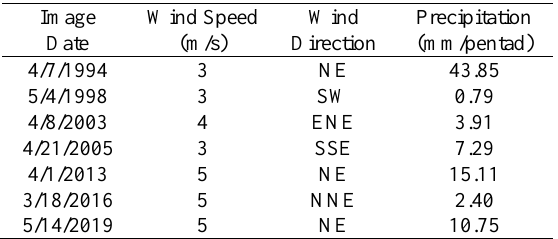
Table 3. Meteorological data on the study site during each mage